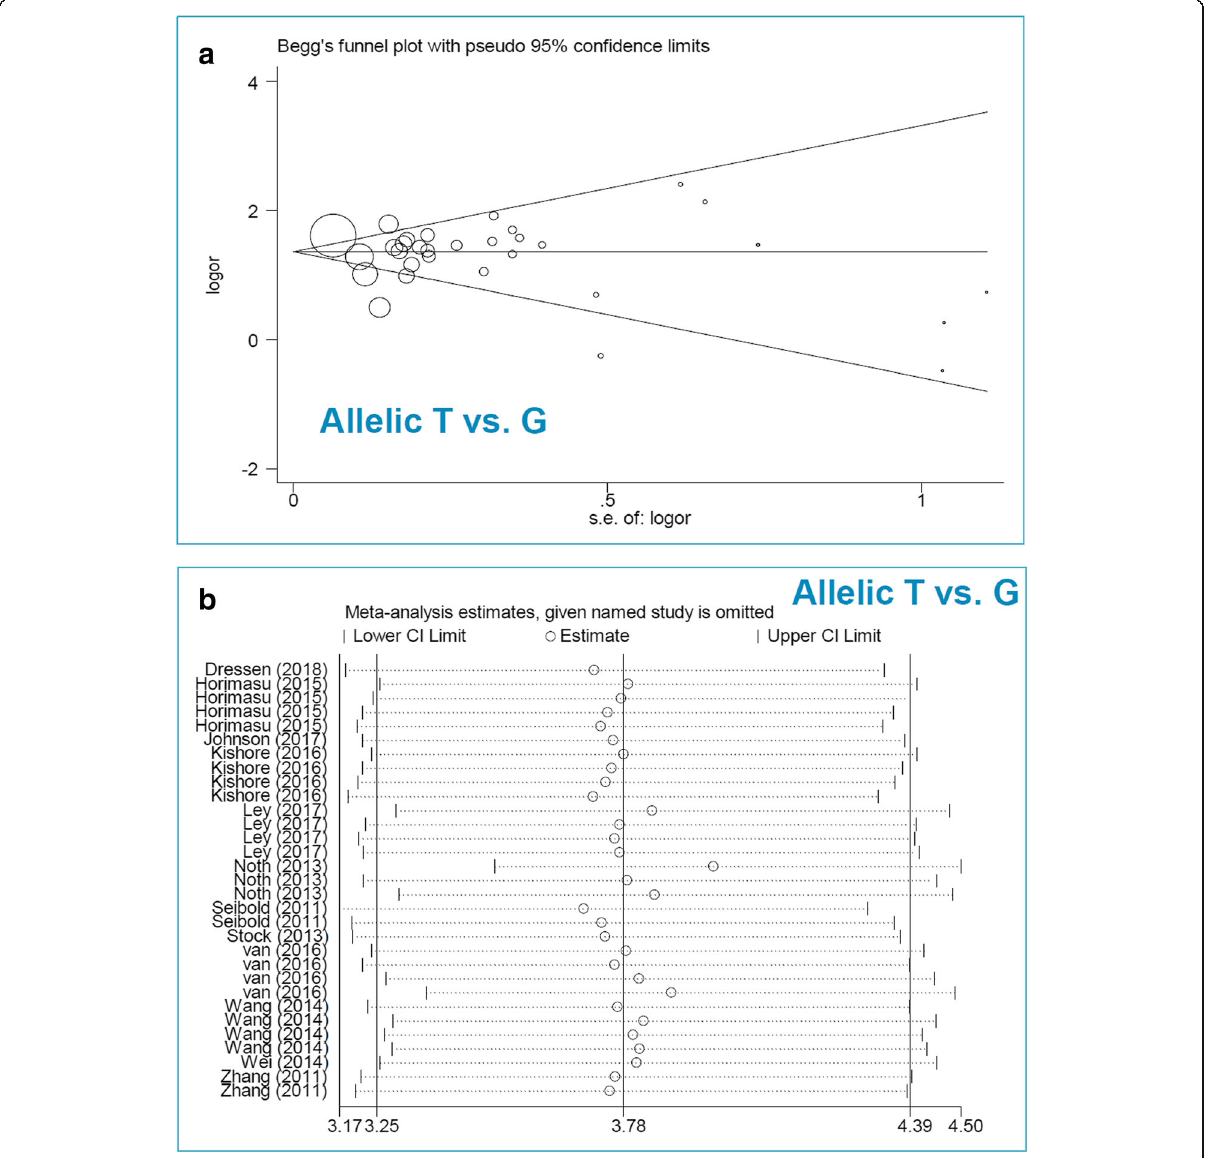
Fig. 5 Sensitivity analysis and Begg test plot for MUC5B rs35705950 under the allelic model. a Sensitivity analysis data; b Begg